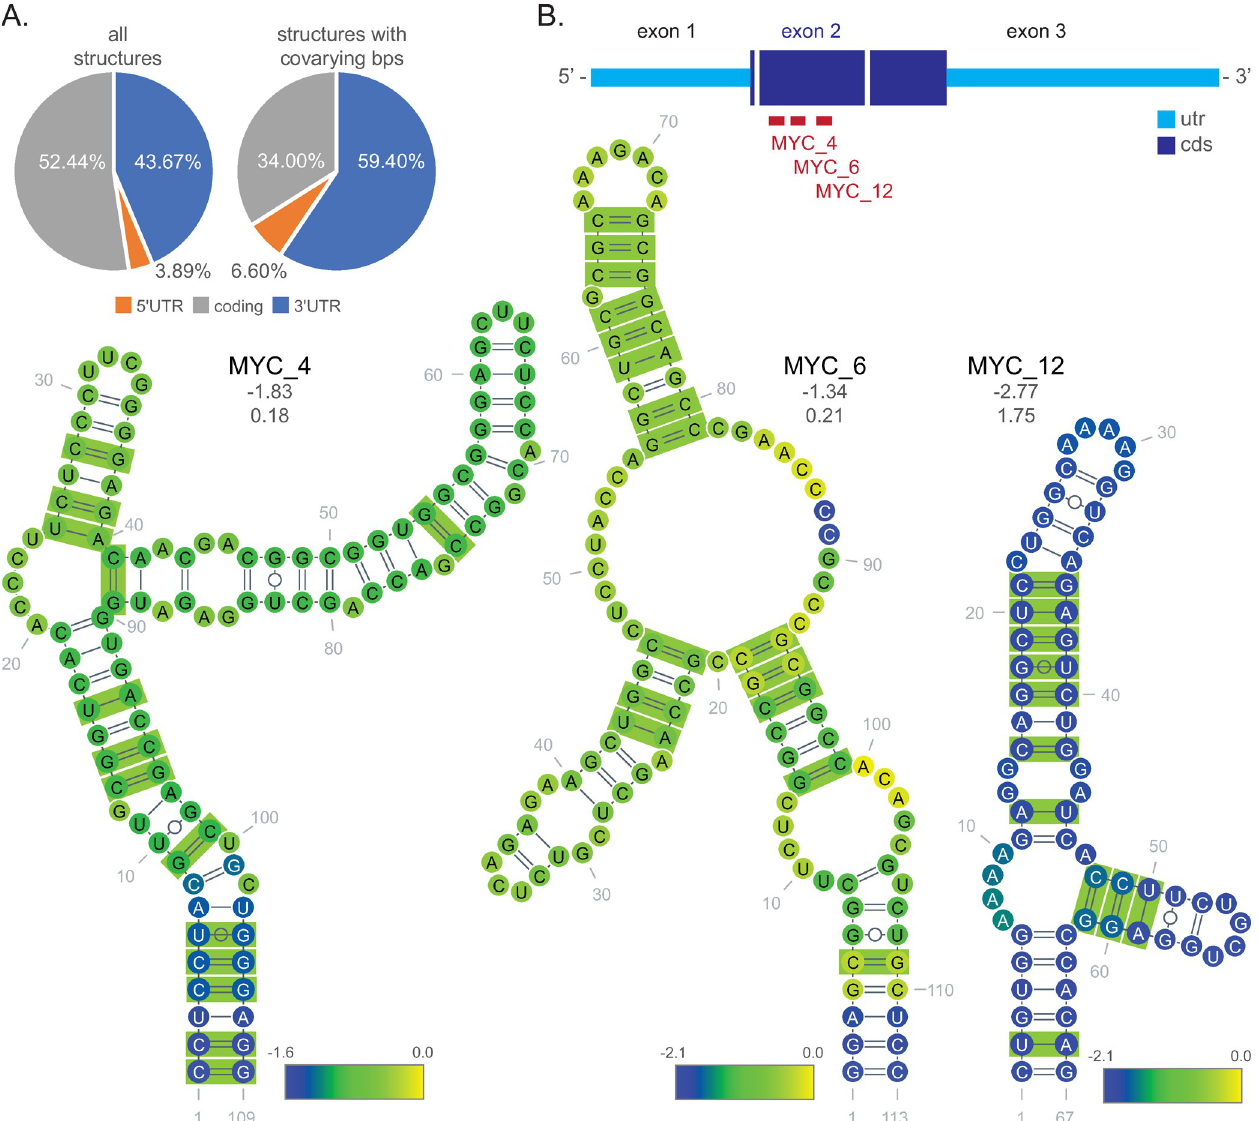
Fig 5. Location of structure analysis and coding structure examples. (A) Graph of UTR and coding region percentages across all identified structures (left) and the subset of structures that had at least one covarying base pair (right). (B) Schematic of MYC transcript showing the location of three conserved structures in exon 2. Secondary structures are shown below with covarying base pairs denoted in green boxes (R-scape). Base coloring indicates per nucleotide z-score mean. Values of the structure z-score (not the average of per nucleotide windows) and the Zcm are provided under the structure names, respectively.